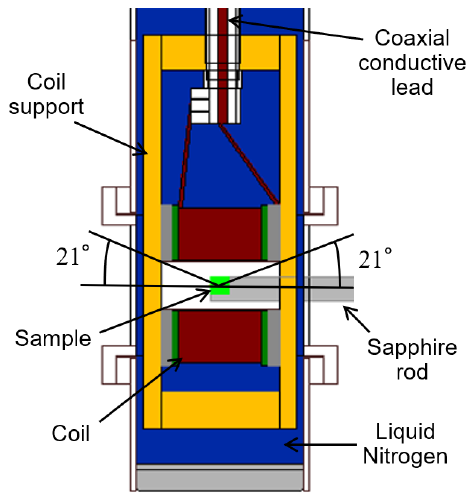
Figure 5. Enlarged cross-sectional view around the coil.